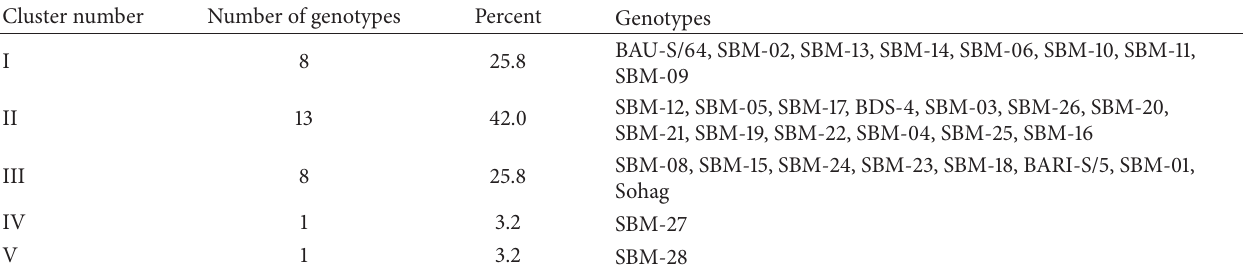
Table 8: Groups of 27 soybean mutants and four mother varieties according to cluster analysis from nine phenological and morphological characters, yield attributes, and seed